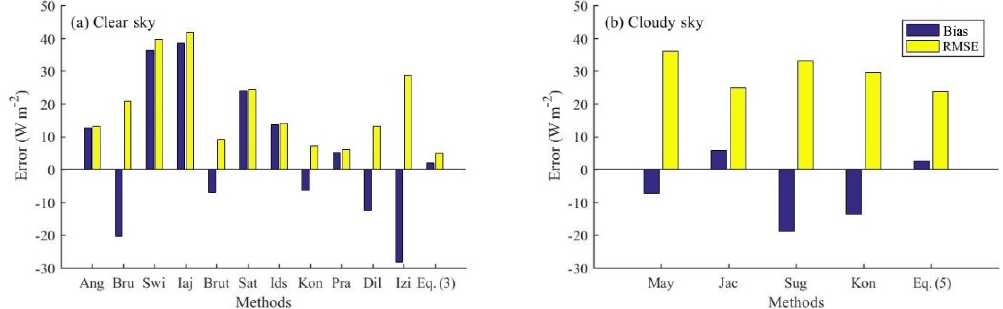
Figure 5. Bias and RMSE for the DLR parametrizations using (a) the published clear-sky parametrizations and Eq. (3) and (b) cloudy-sky parametrizations and Eq. (5).